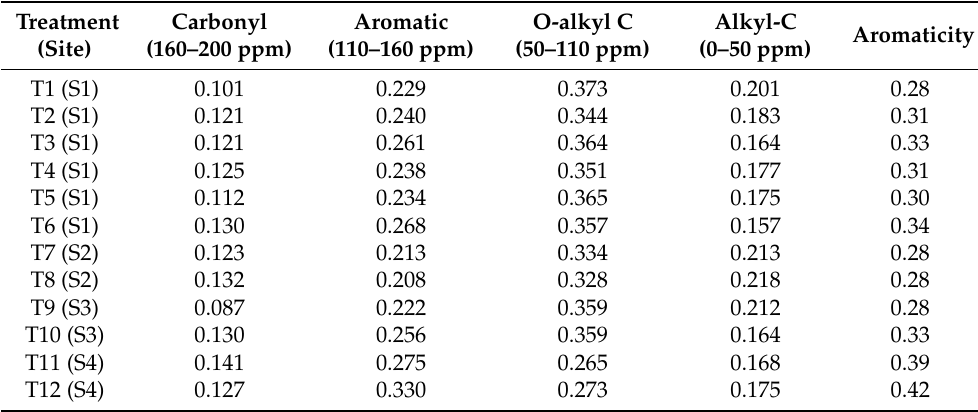
Table 4. Relative intensity of C functional groups in HAs measured by SS-13CPMAS-NMR.